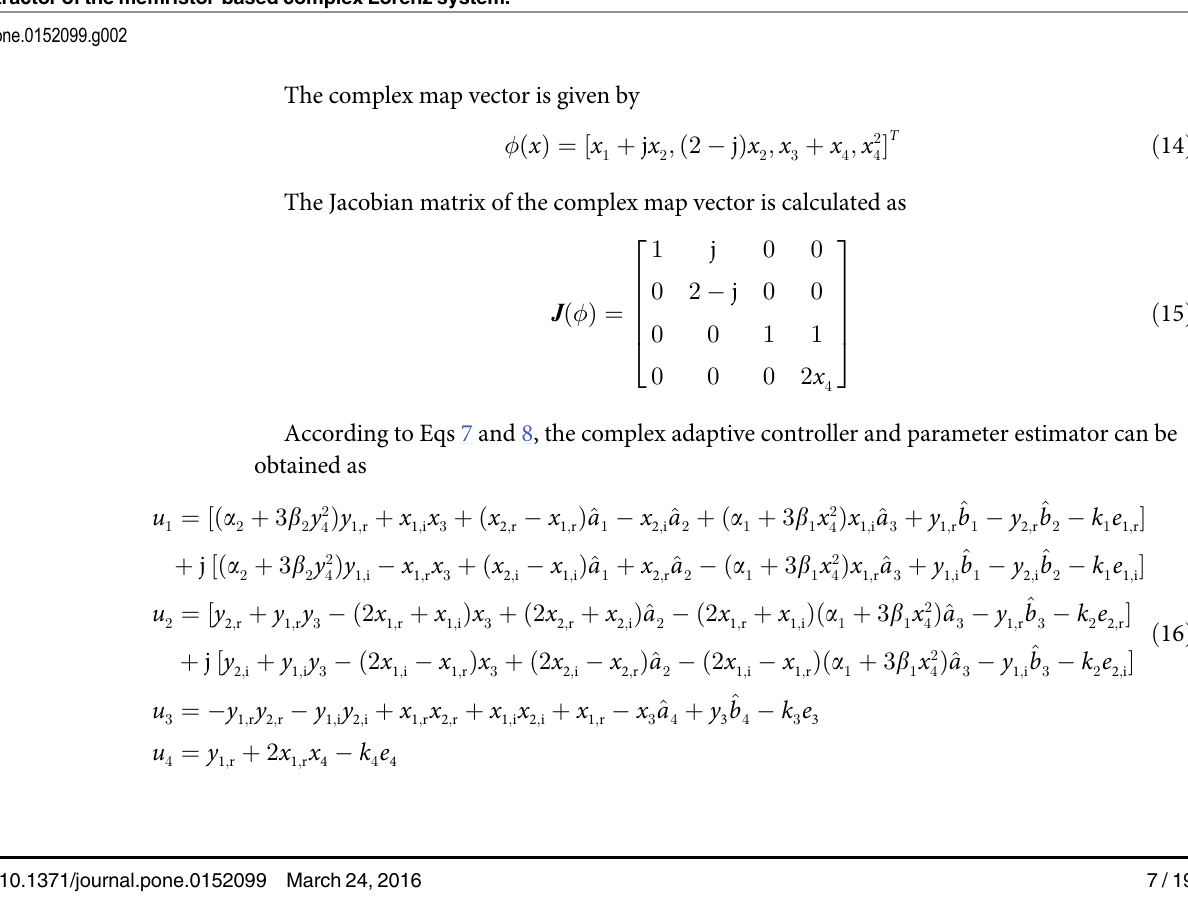
Fig 2. Chaotic attractor of the memristor-based complex Lorenz